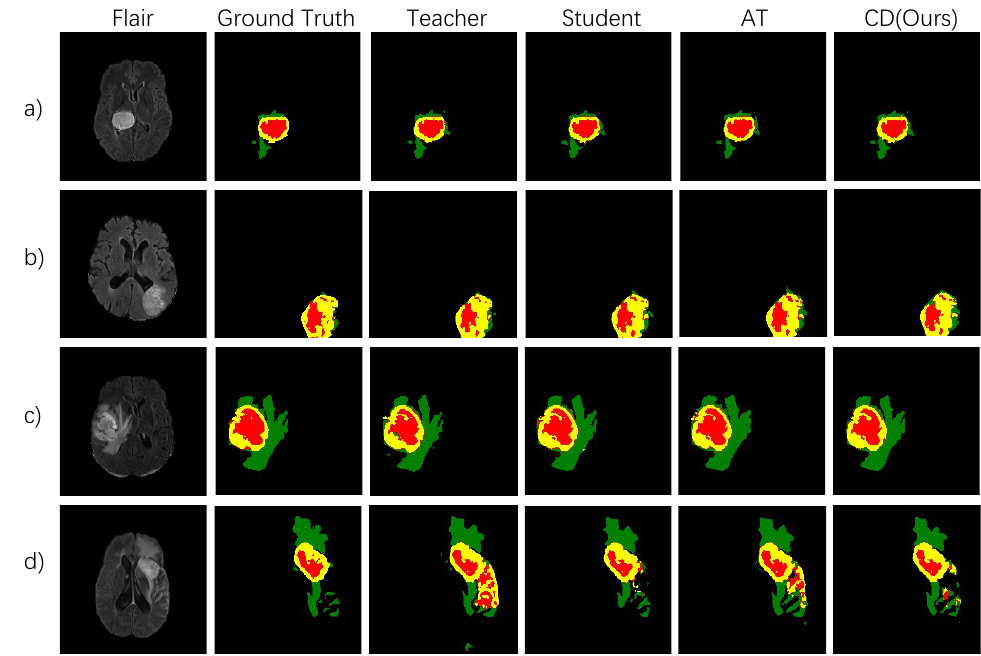
Figure 3. The segmentation results were obtained by applying our distillation method in four cases ( a – d ) of the BraTS validation dataset. ET—yellow, TC—yellow+red, WT—yellow+red+green. The teacher was UNet and the student was DeepResUNet.